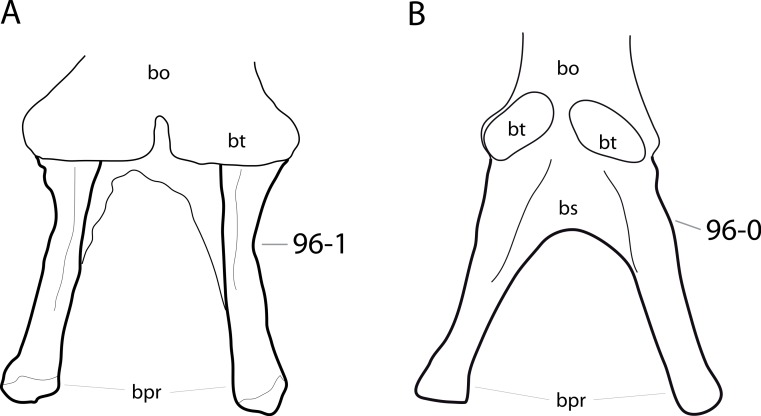
Diplodocine basisphenoids.Basisphenoid of Kaatedocus siberi SMA 0004 (A; traced from a photo by J Marinheiro), and Diplodocus sp. CM 11161 (B) in posteroventral view. Note the parallel proximal portion of the basipterygoid processes and the accompanying outwards curve in Kaatedocus (A; C96-1), in contrast to the straight processes of CM 11161 (B; C96-0). Abb.: bo, basioccipital; bpr, basipterygoid process; bs, basisphenoid; bt, basal tuber. Scaled to the same process length.